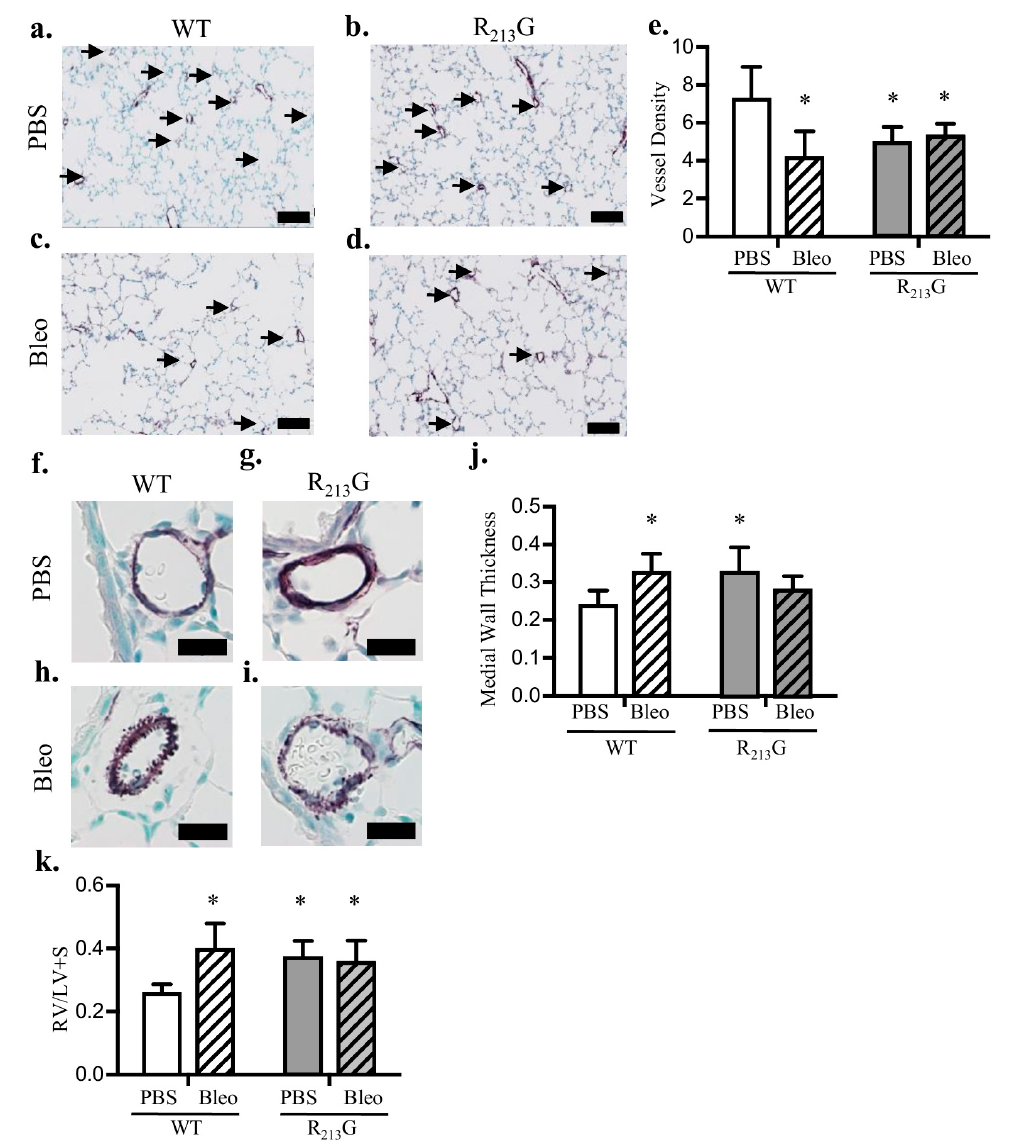
Figure 5. Bleomycin did not further impair the baseline pulmonary vascular impairment or